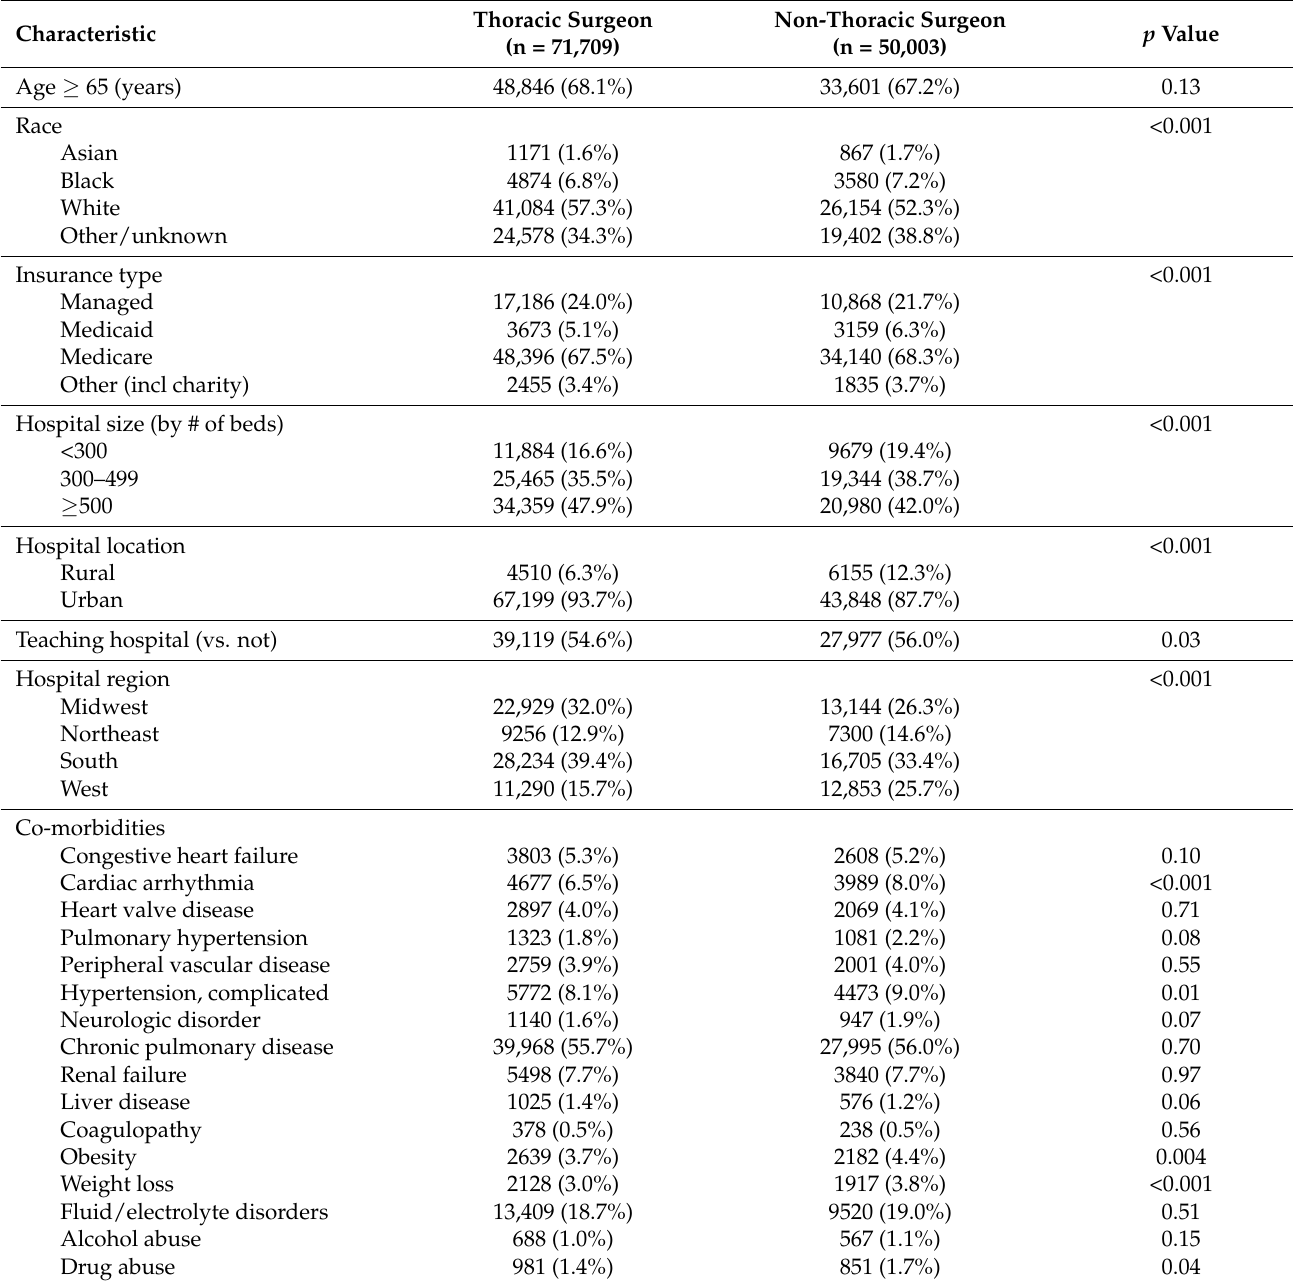
Table 1. Description of cohort of patients in the Premier Healthcare Database (2009 to 2019) stratified by type of provider (thoracic surgeon vs. non-thoracic surgeon) performing the